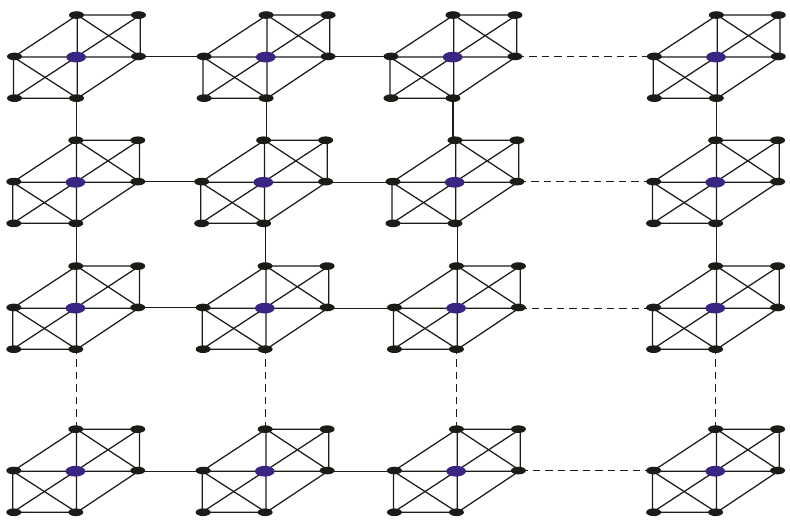
Figure 1: Structure of rhenium